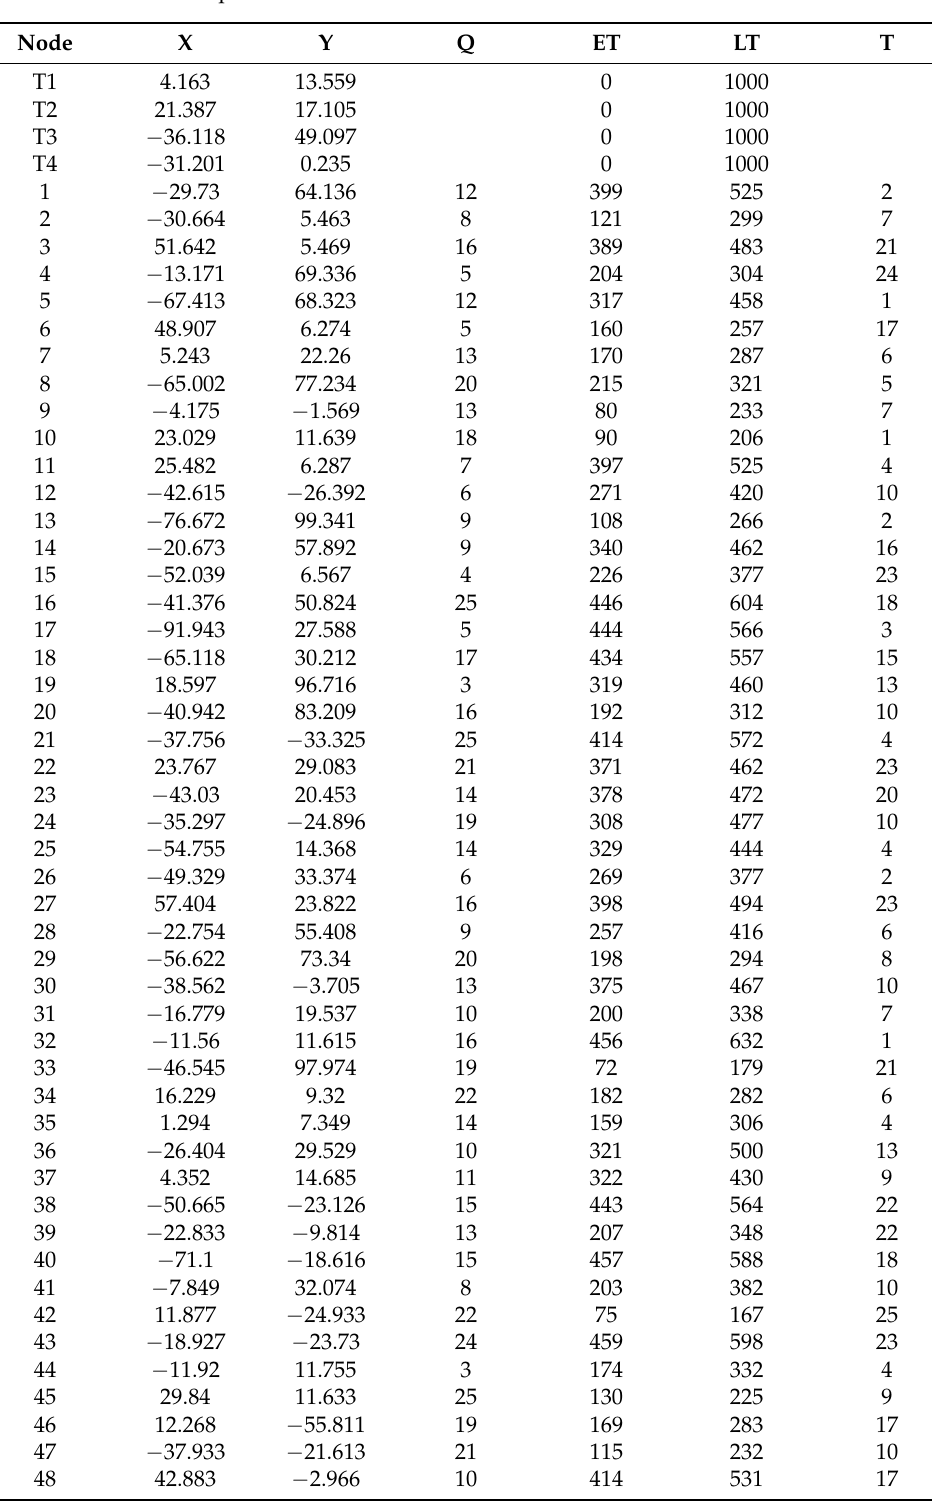
Table 4. Information for pr01 benchmark